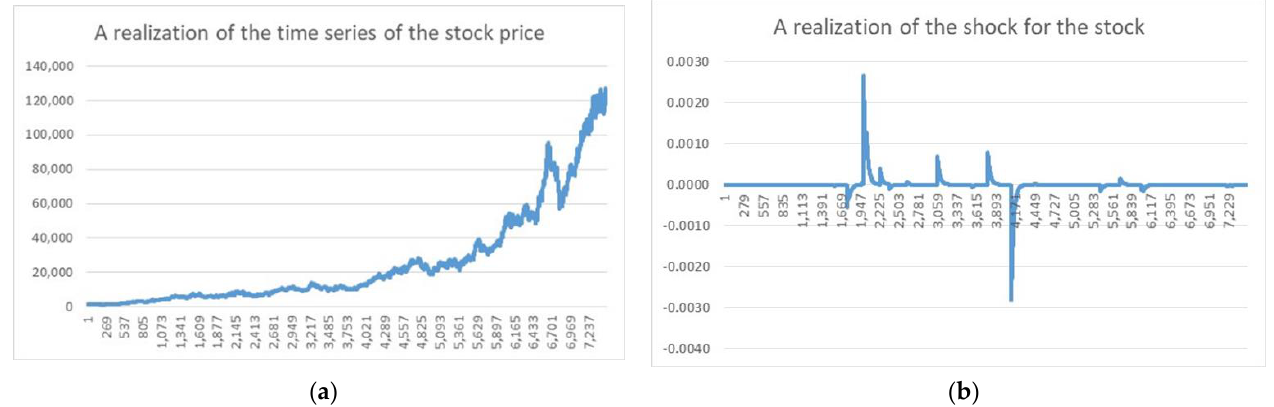
Figure 2. ( a ) Realization of the stock price; ( b ) Realization of the shocks. Table 3. The parameters of the shock simulation. Table 3. The parameters of the shock simulation. Shock Parameter Affecting the Value of the Shock Shock Parameter Affecting the Value of the Shock